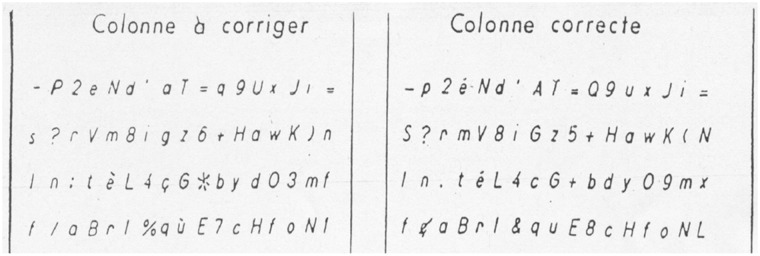
K-T cancellation test.